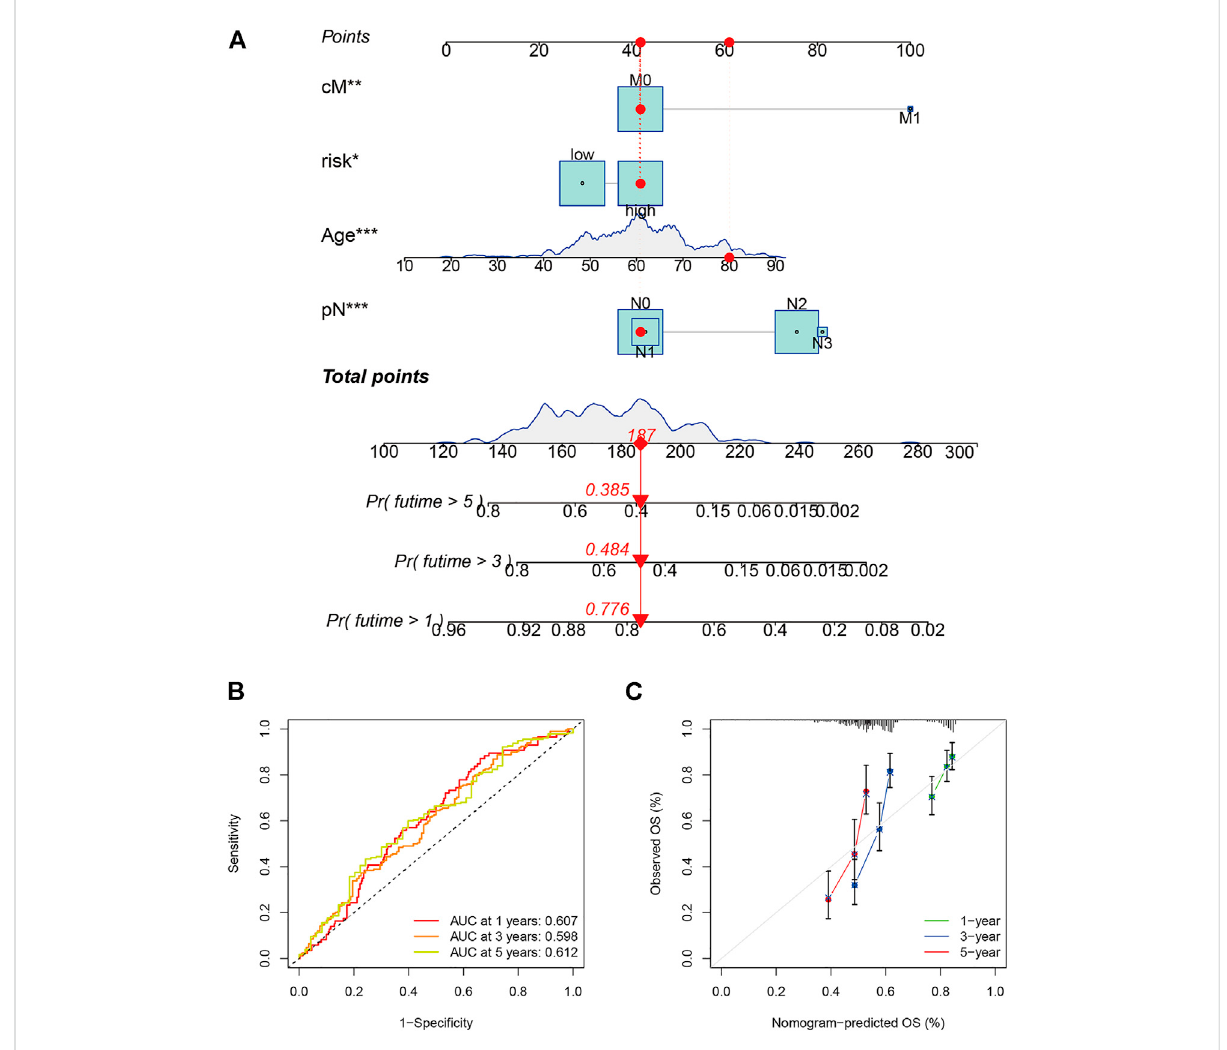
FIGURE 4 Evaluation and development of the prognostic model. (A) Prognostic model (nomogram) constructed using the “ rms ” R package; (B) The area underthe curves for 1-, 3-, and 5-years clinical outcomes(0.607, 0.598, and 0.612,respectively). The values indicate good predictive power; and (C) Calibration plots re fl ect the agreement between the predicted and actual survival